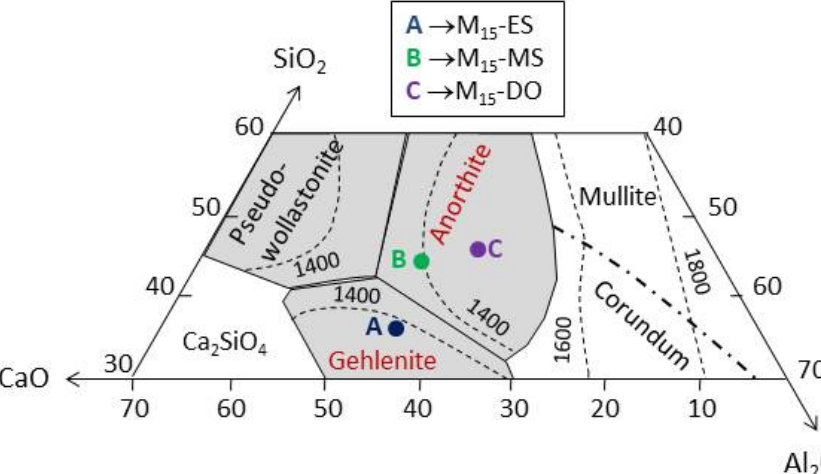
Figure 7. SiO 2 -Al 2 O 3 -CaO ternary phase diagram. [28].